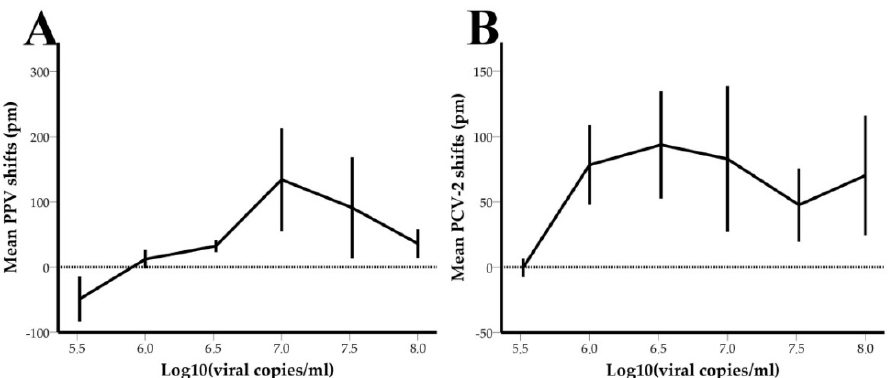
Figure 7. PPV ( A ) and PCV2 ( B ) shift responses (in pm) plotted against viral concentrations (log 10 (Viral copies/mL)).